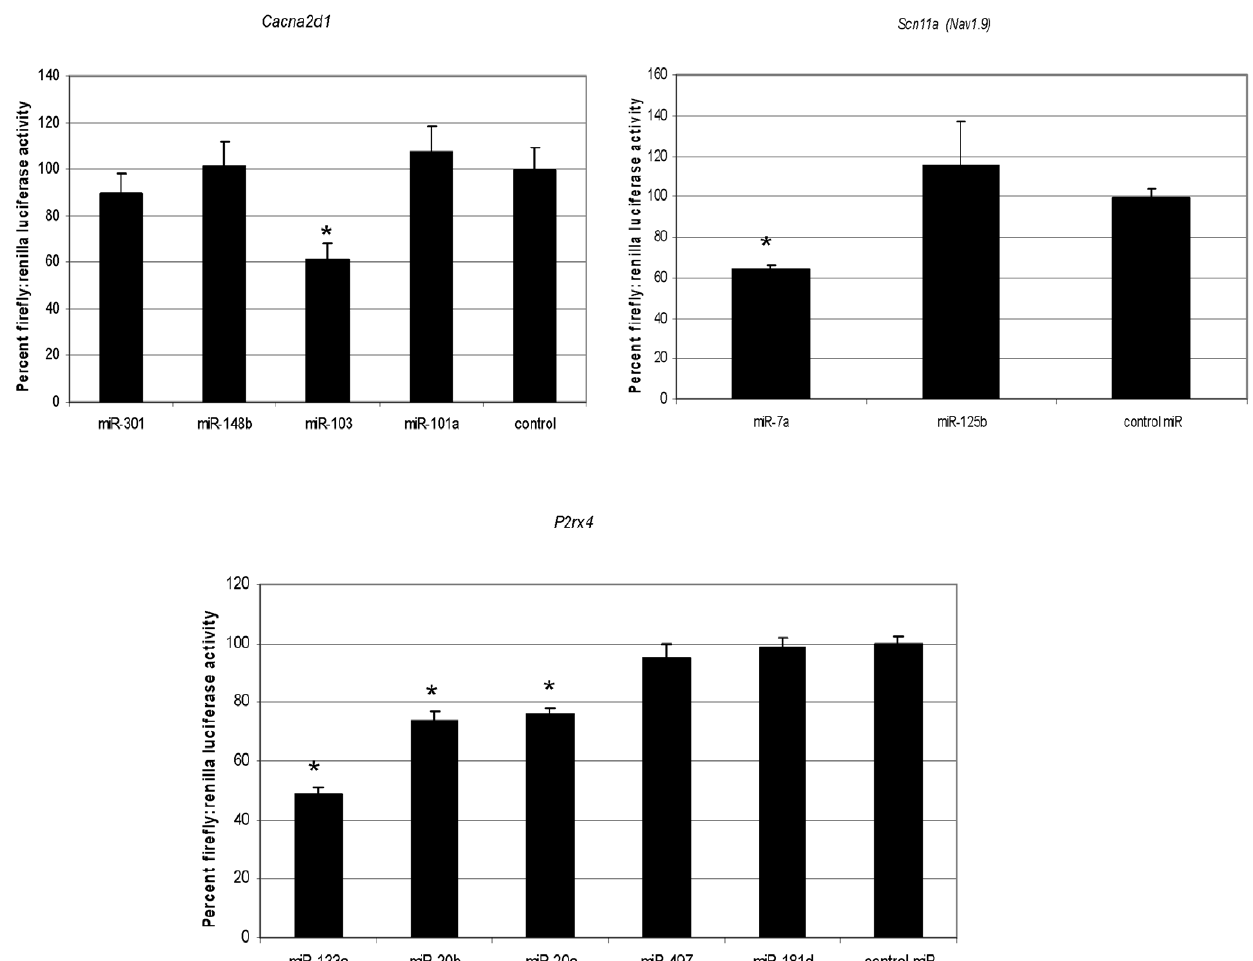
Figure 2. Luciferase reporter gene assay to assess the effect of miRNA on gene function. The effect of miRNA on gene regulation was monitored by co-transfecting 100 nM miRNA and the luciferase reporter gene. The 3 9 -UTR of Scn11a ( Nav1.9 ), Cacna2d1 and P2rx4 were cloned downstream of the luciferase open reading frame. In addition to miRNAs that could bind to the corresponding UTR, negative control pre-miRNA was transfected with the corresponding luciferase reporter plasmid for each gene analyzed. The luciferase activity was measured 24 hrs after transfection and the ratio of firefly:renilla luciferase is expressed as percentage of control 6 standard deviation shown. A statistically significant difference from control miRNA was calculated using one-way ANOVA and p -value of , 0.003 are represented by * in the figure.